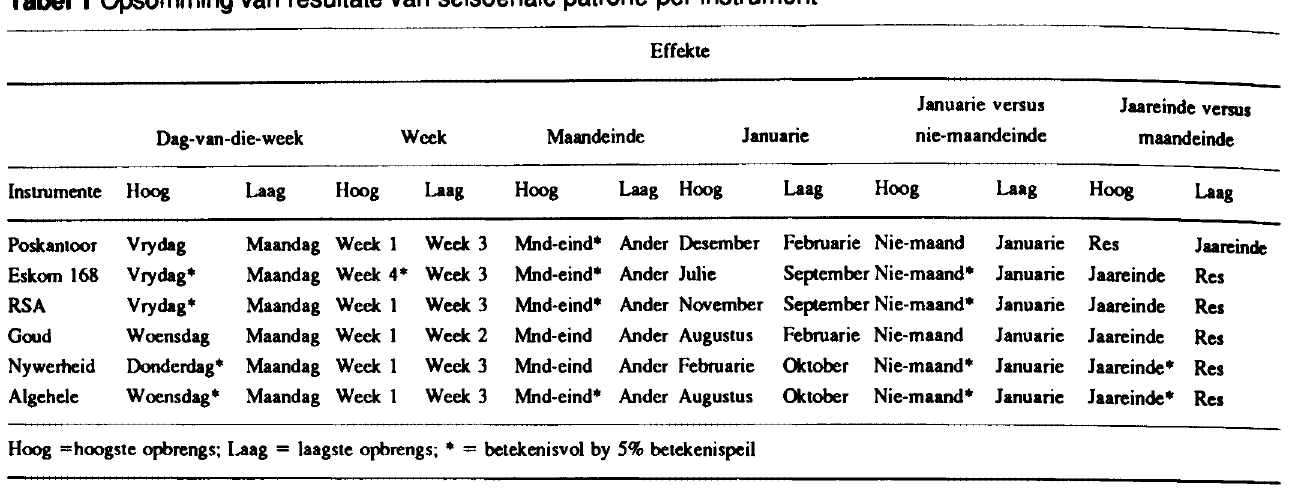
Tabel 1 Opsomming van resultate van seisoenale patrone per